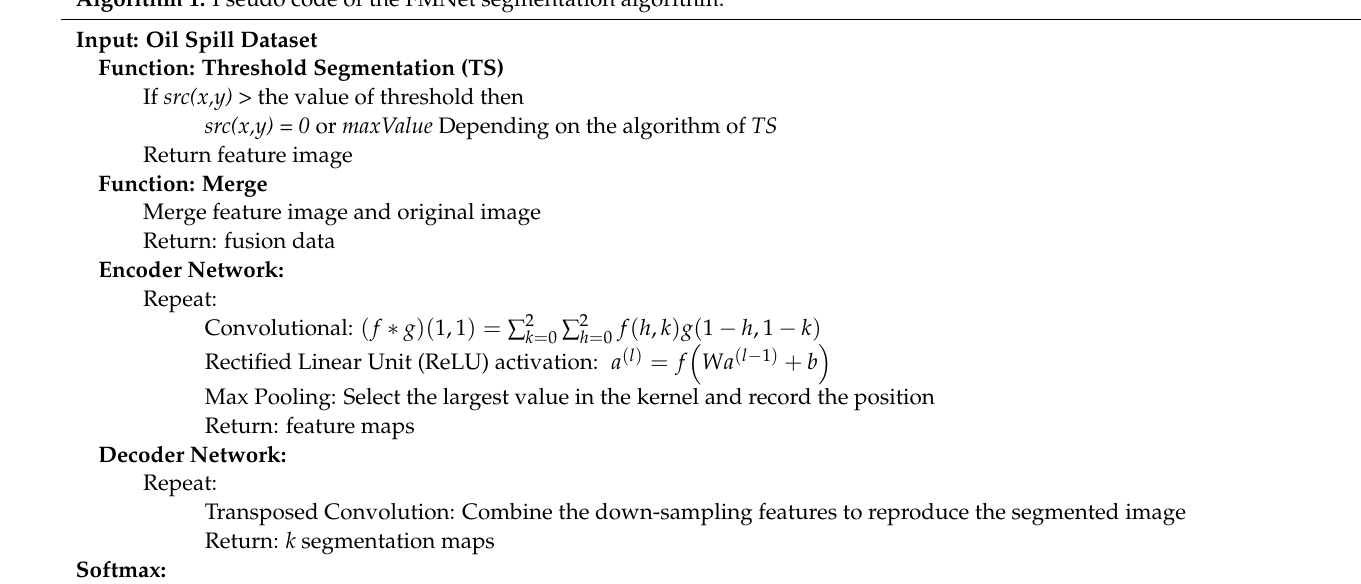
Algorithm 1. Pseudo code of the FMNet segmentation algorithm.